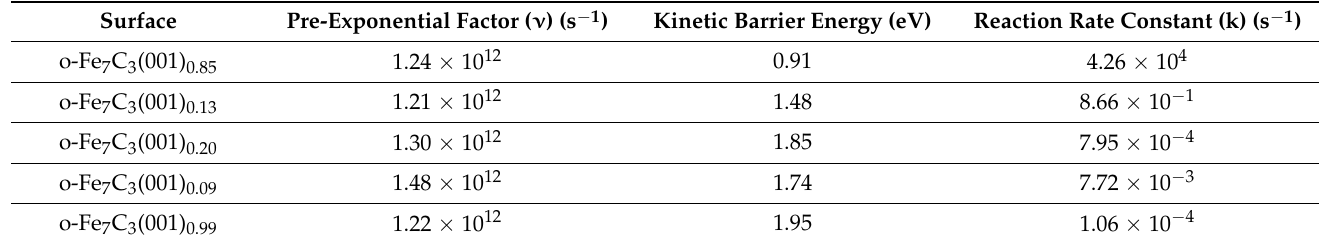
Table 2. Pre-exponential factors and reaction rate constants for CO* dissociation on o-Fe 7 C 3 (001) surfaces.